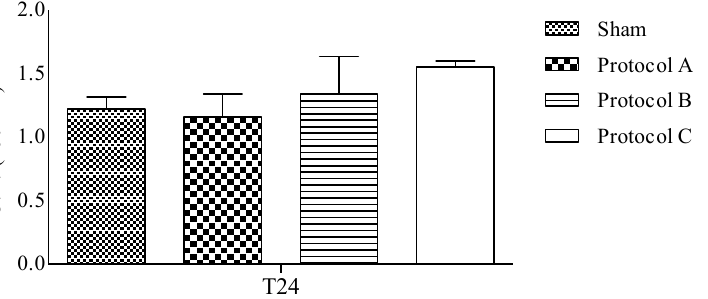
Figure 1. MTT assay. HaCaT proliferation rate was evaluated after each RF-EMF-exposure setup and the sham exposure. Combined data were from three experiments and are reported as mean ± SD of O.D. values.